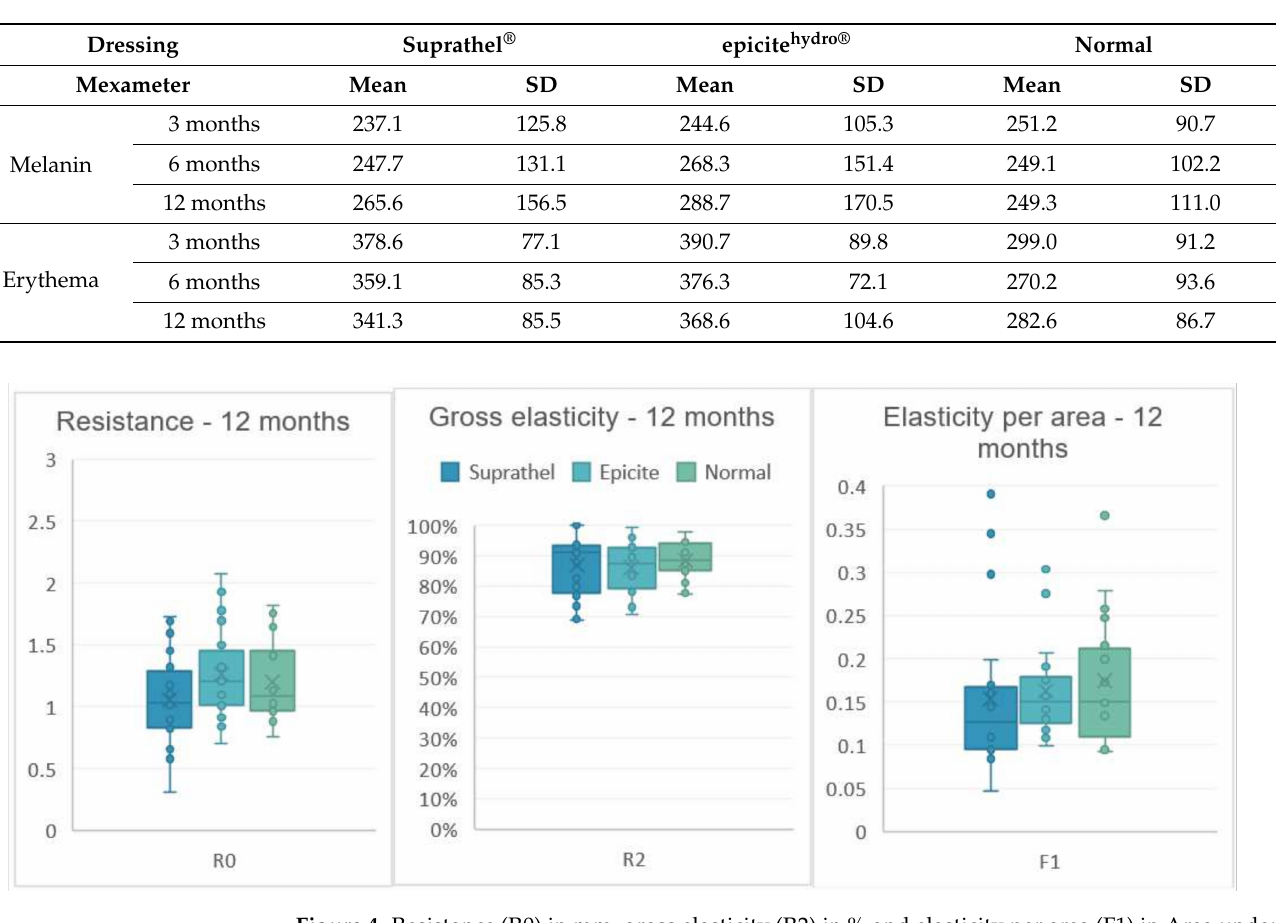
Figure 4. Resistance (R0) in mm, gross elasticity (R2) in % and elasticity per area (F1) in Area under the curve of treated and untreated areas after 12 months. Table 3. Tewameter measurements in mean and SD(standard derivation) in g/h/m 2 after 3,6 and 12 months of treated and untreated